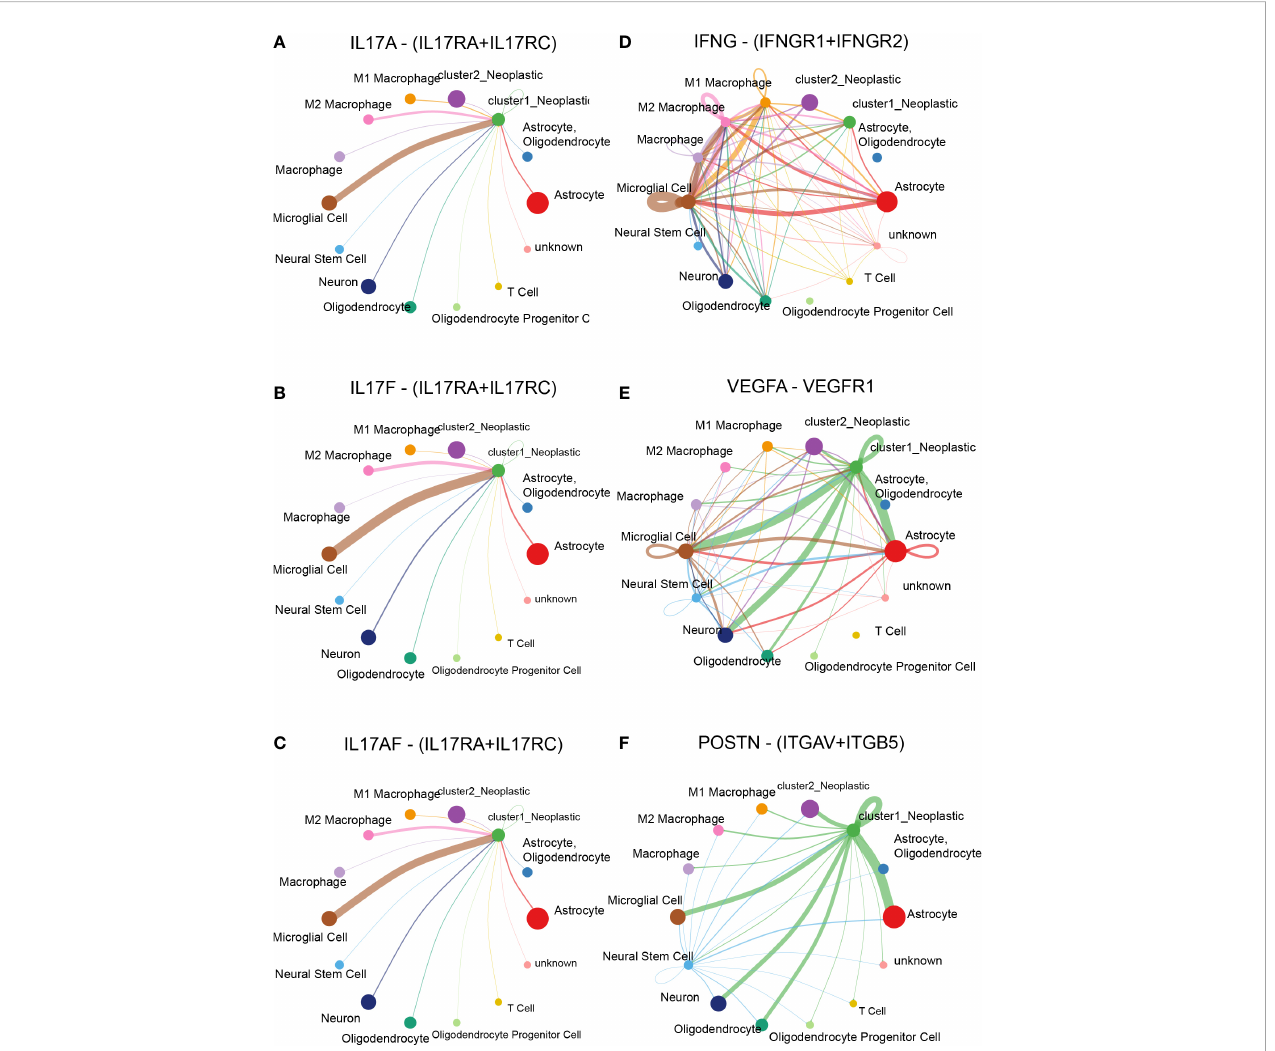
FIGURE 7 Cell – cell interaction based on the cluster model in single-cell RNA-seq analysis. Ligand – receptor pair difference between cluster 1 and cluster 2 samples, including IL17A-(IL17RA+IL17RC) (A) , IL17F-(IL17RA+IL17RC) (B) , IL17AF-(IL17RA+IL17RC) (C) , IFNG-(IFNGR1+IFNGR2) (D) , VEGFA-VEGFR1 (E) , and POSTN-(ITGAV+ITGB5) (F)